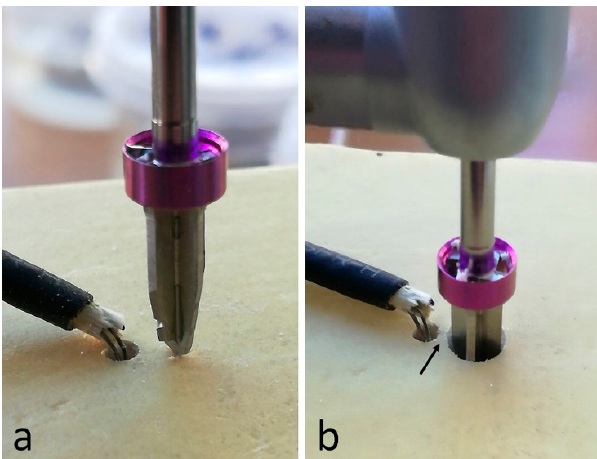
Figure 3. The thermocouple type k positioned in the perforation and the drill positioned before starting the osteotomy ( a ) and after the osteotomy finished ( b ), where the arrow indicates the distance of 1 mm to the sensor.